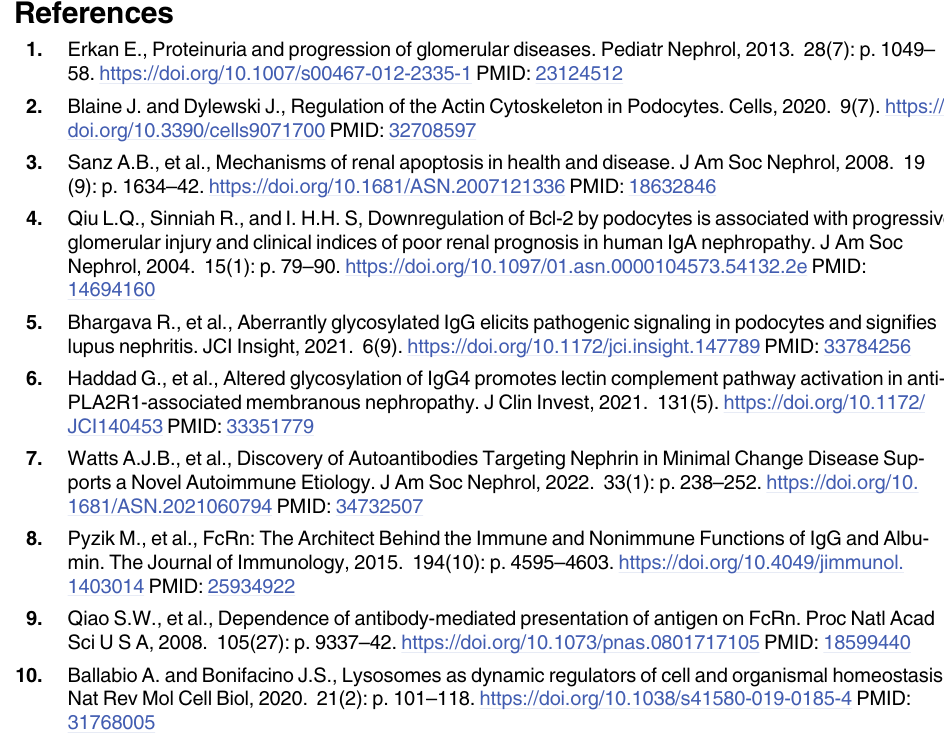
S1 Fig. Uncropped western blot gels for western blot images in Figs 4 and 6. For Fig 4, uncropped gels are shown for LAMP1 at 4 hours, cathepsin B at 4 hours, LAMP1 at 48 hours, cathepsin B at 48 hours and corresponding beta-actin for each gel. For Fig 6, uncropped gels are shown for NP-ovalbumin (NP-Ova), IgG and immune complex (IC)- treated WT and KO podocytes for phospho-Akt (pAkt), total Akt, phosphor-ERK1/2, total ERK1/2 and corre- sponding beta-actin